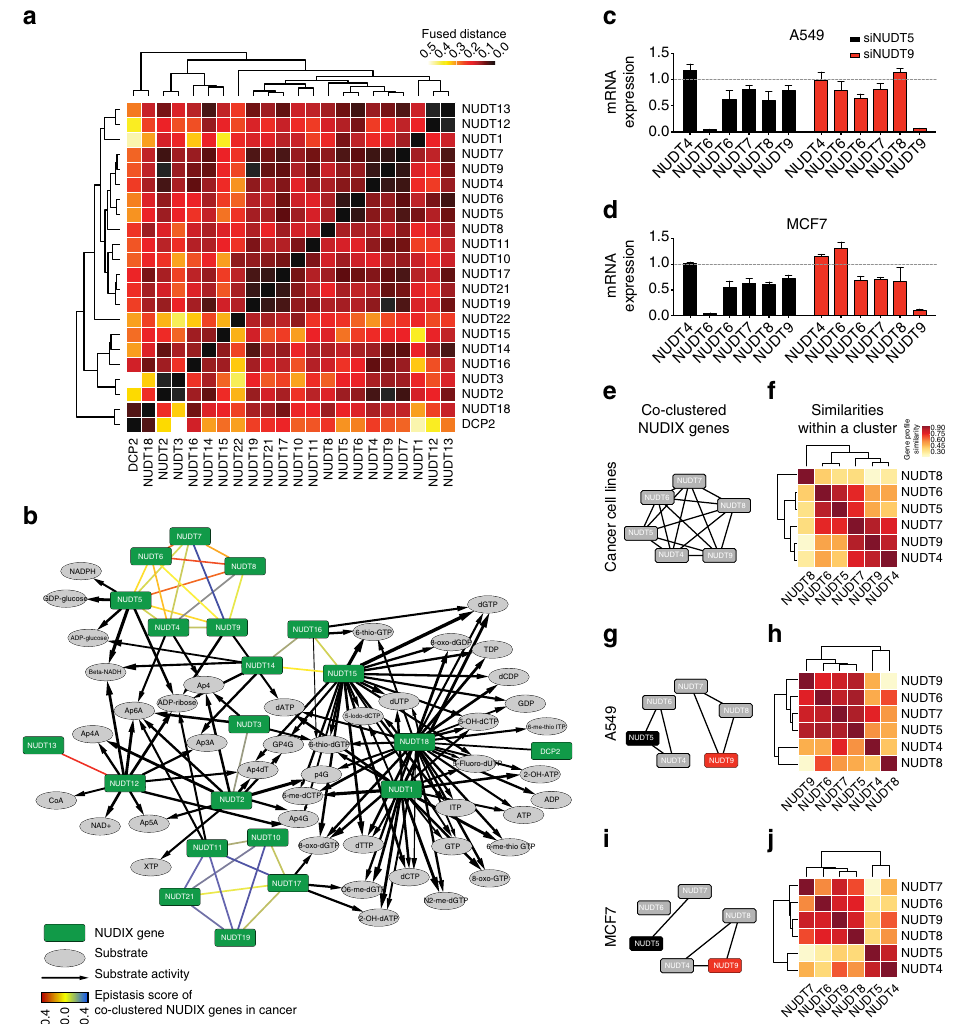
Fig. 8 Clustering of the human NUDIX family. Integrative analysis of 27 data sets from public data repositories, such as TCGA and the HPA, as well as experimental data (Supplementary Fig. 6). a Detailed hierarchy of NUDIX clusters represented with a dendrogram and a heat map. Shown are distances between vector representations of NUDIX enzymes. b Integrative clustering analysis of the NUDIX enzymes. Enzymes in the same cluster are linked with undirected edges in the network, colored based on the epistasis score. The substrate activity data is added to the same network, relating clusters of NUDIX enzymes. c , d Effect of siRNA-mediated knockdowns of NUDT5 and NUDT9 on the mRNA expression levels of the interrogated NUDIX genes in A549 and MCF7 cells. e Cluster of NUDT4, NUDT5, NUDT6, NUDT7, NUDT8, and NUDT9, which is the largest identi fi ed by the integrated analysis. f Similarities between members of the interrogated cluster reveal internal structure of the cluster. Darker color indicates greater similarity. g , h When integrating 11 data sets that were related in A549 cell line, NUDT4, NUDT5, and NUDT6 were clustered together, but placed in a different cluster than NUDT7, NUDT8, and NUDT9. Heat map showing similarity of vector representations of the enzymes, whereby these representations were derived from the model of 11 data sets describing A549 data. i , j Similar to g , h , but in this case 10 data sets originated from MCF7 cells were considered for the